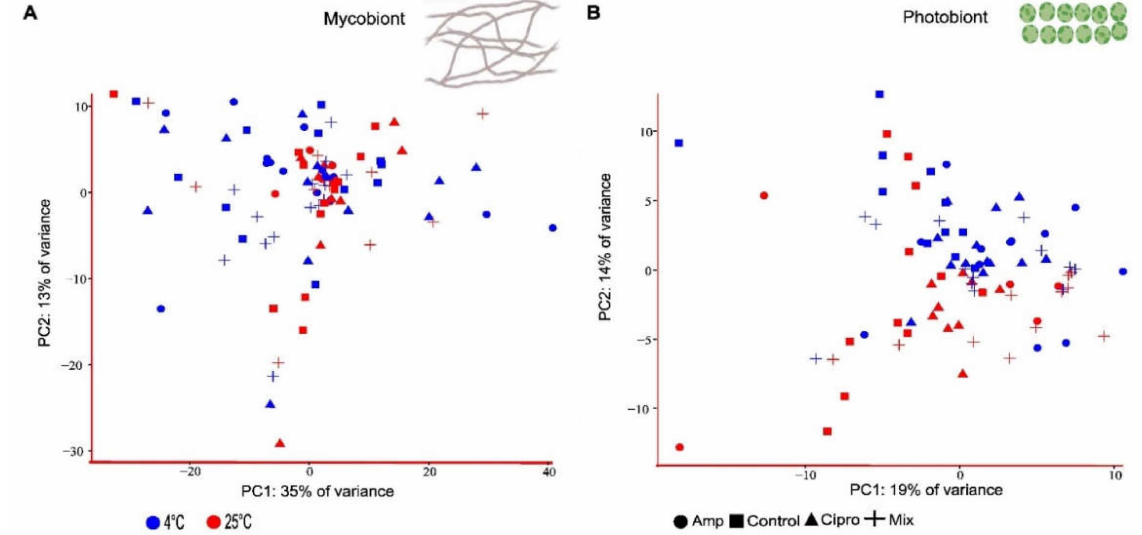
Figure 2. Principal component analysis of gene expression count data for Lobaria pulmonaria included in the antibiotic experiment (see Figure 1). Color-coding represents the temperatures that the samples were exposed to: blue (low temperature, 4 ◦ C), and red (high temperature, 25 ◦ C), symbols repre- sent different treatments. Amp, Ampicillin; Mix, Ampicillin + Ciprofloxacin; Cipro, Ciprofloxacin. ( A ) Mycobiont ( B ) Photobiont (n = 96